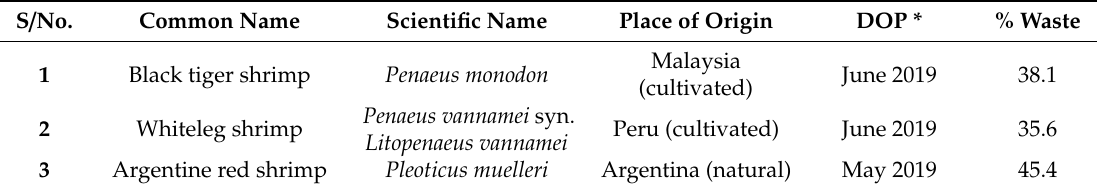
Table 1. List of shrimp samples procured for the study and the amount of waste generated from each species. S /